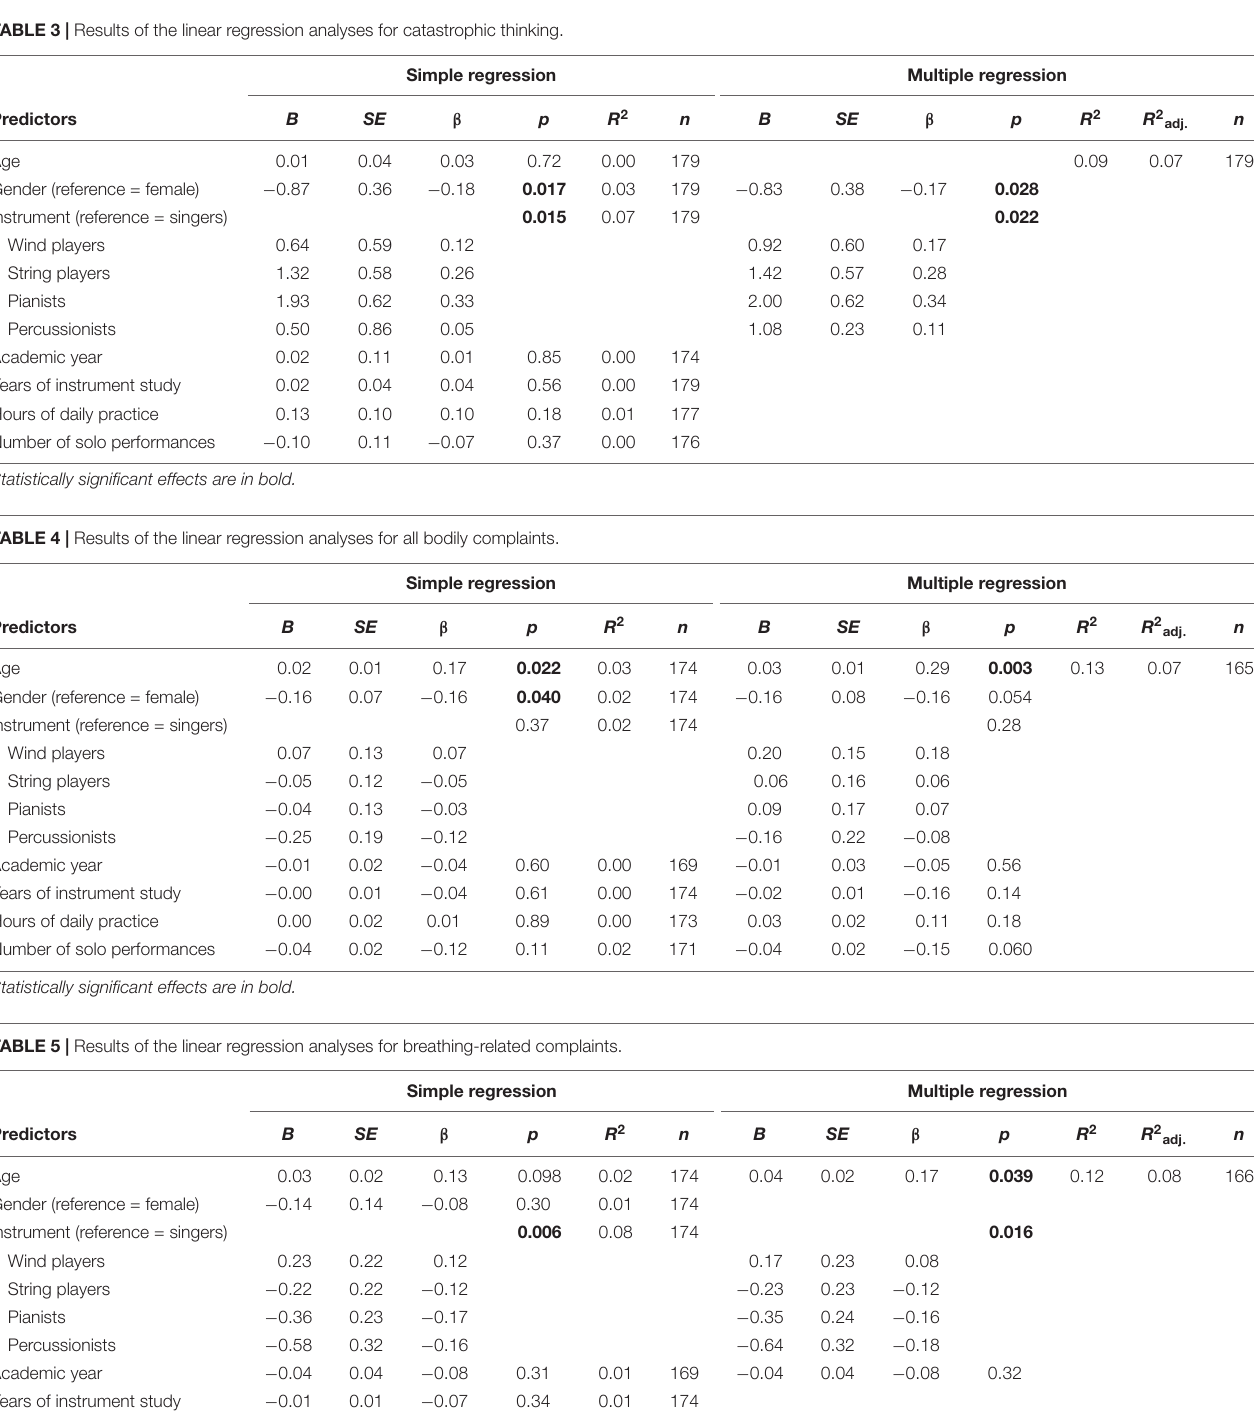
TABLE 3 | Results of the linear regression analyses for catastrophic thinking. Simple regression Multiple regression